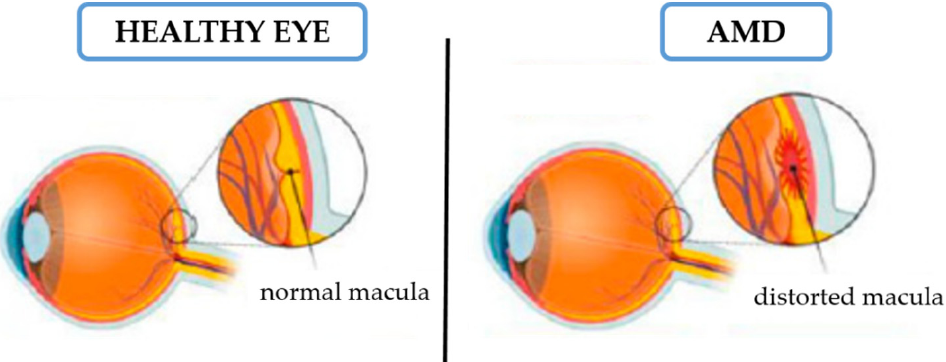
Figure 1. Appearance of macula in a healthy (left) and in a damaged (right) eye (reproduced from Fernandes et al. (2022) [2], CC BY license).